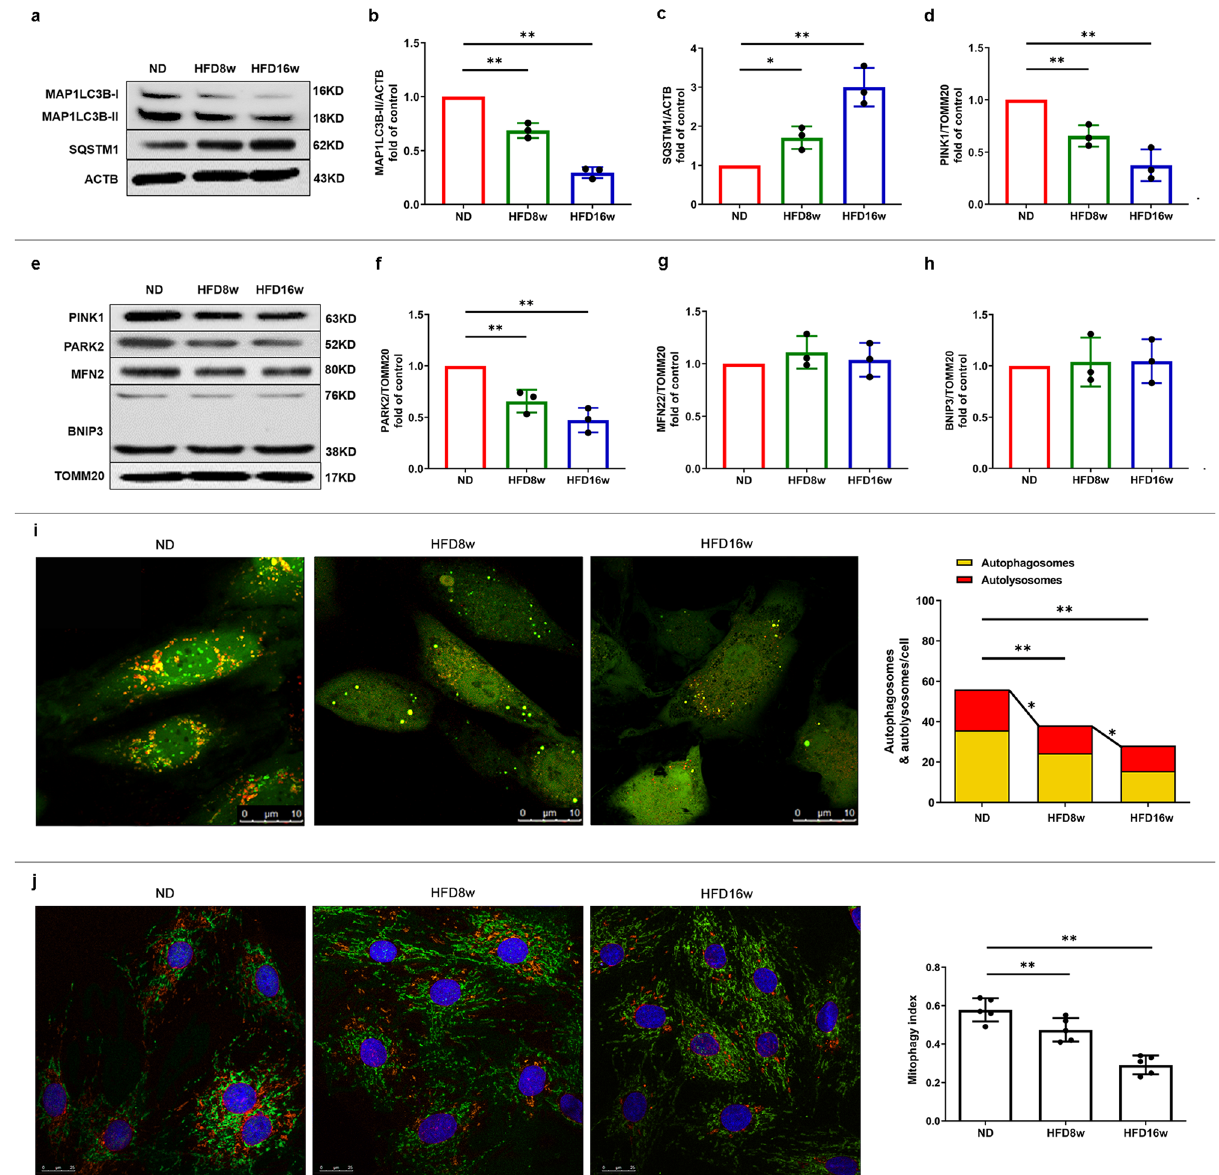
Fig. 2 Mitophagy was impaired in atherosclerotic mice. a Western blots revealed that MAP1LC3B-II turnover decreased ( b ) and the expression of SQSTM1 increased ( c ) signi fi cantly in atherosclerotic mice. e Representative western blots of mitophagic proteins in EPCs of atherosclerotic mice. ( d , f ) Quantitative analysis indicated that both the expression of PINK1 and PARK2 decreased on the mitochondrial membrane in EPCs of atherosclerotic mice. ( g , h ) Quantitative analysis revealed that MFN and BNIP3 showed no markedly difference in EPCs between ND and atherosclerotic mice. i Representative images and quantitative analysis of yellow and free red puncta in merged images in EPCs from ND and atherosclerotic mice, scale bar: 10 μ m. j EPCs from ND and atherosclerotic mice were transfected by mtKeima for 12 h. EPCs from HFD8w and HFD16w ApoE − / − mice showed a signi fi cant lower mitophagy index in comparison to those from ND mice. Scale bar: 25 μ m. (EPCs were isolated from ND, HFD8w and HFD16w ApoE − / − mice, n = 10 cells per group, cells were isolated from 3 mice for 1 experiment, and 3 independent experiments were performed, mean ± SD, * P < 0.05, ** P <